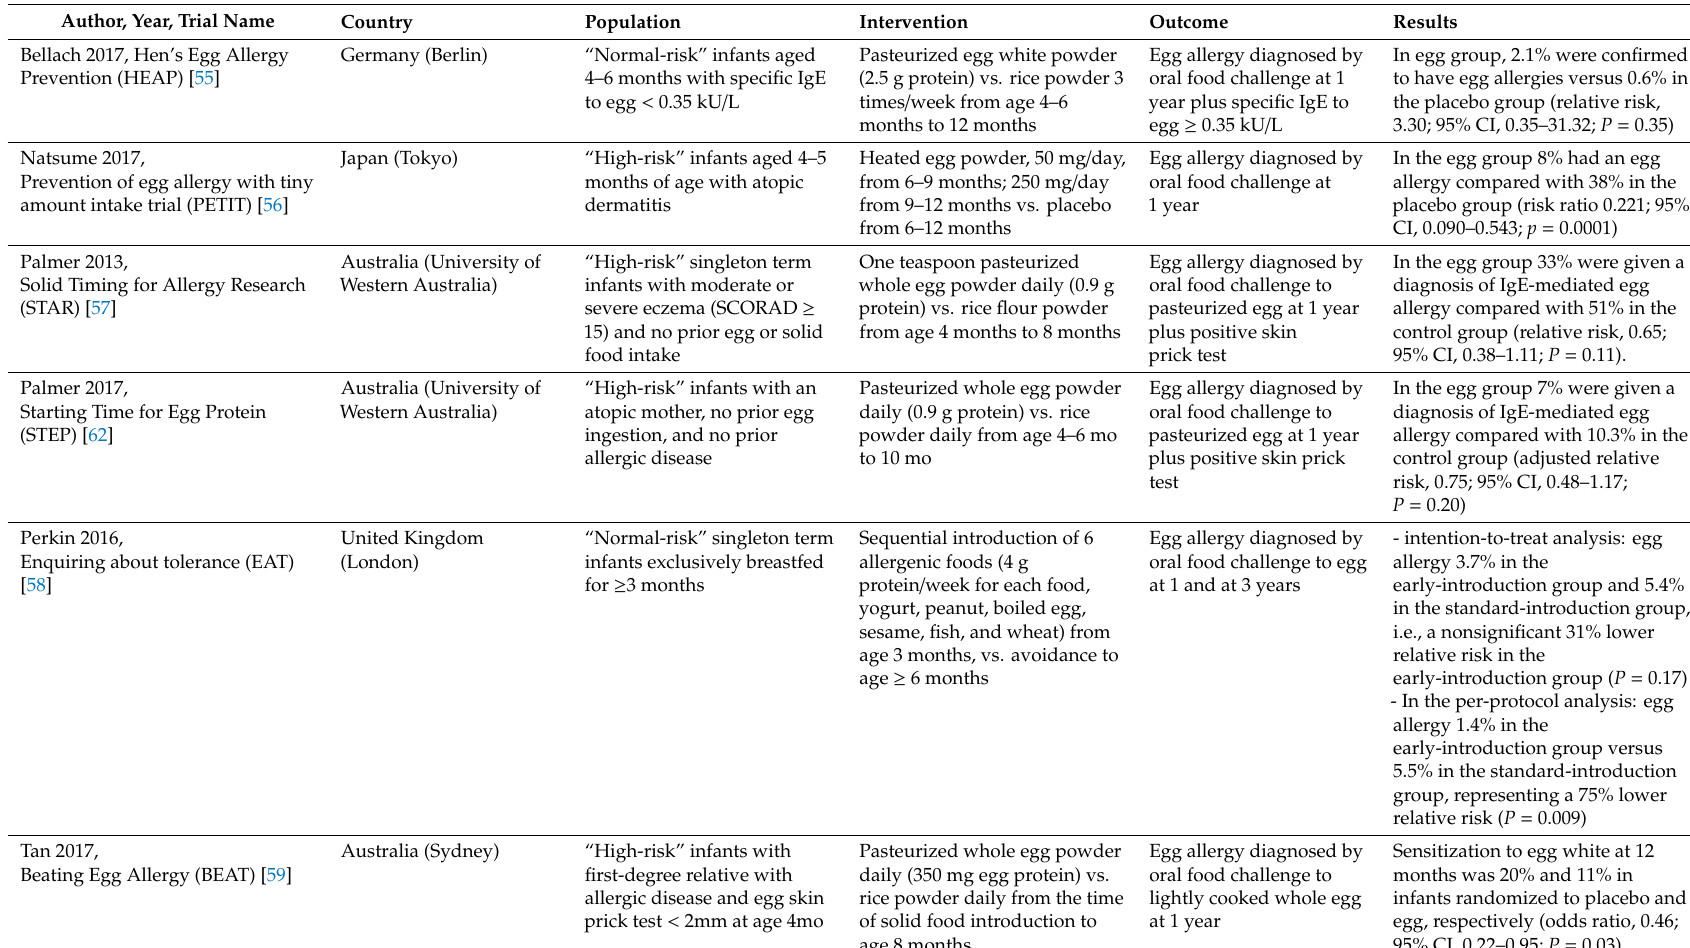
Table 2. Characteristics of Randomized Clinical Trials of Egg Introduction and Risk of Egg